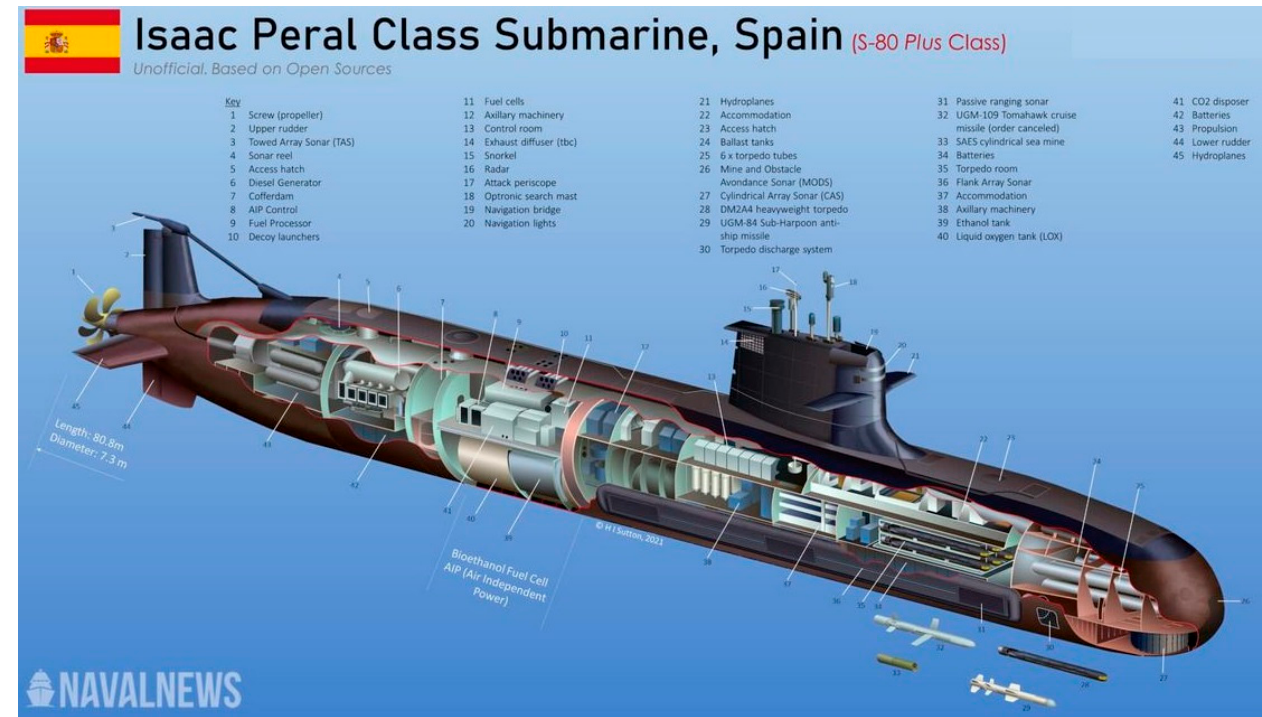
Figure 40. The type S80-Plus submarine [175].